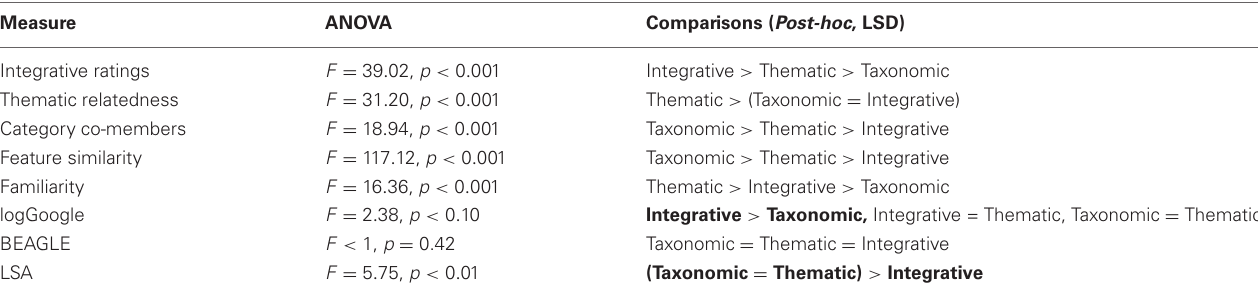
Table 4 | Study 3, differences among relations for each